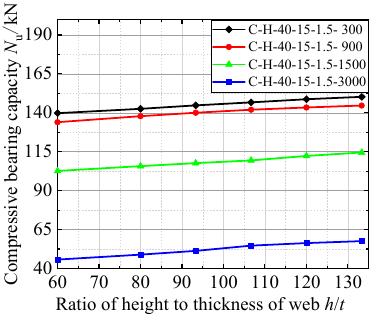
Figure 13. N u - h / t relationship curves of the combined columns.